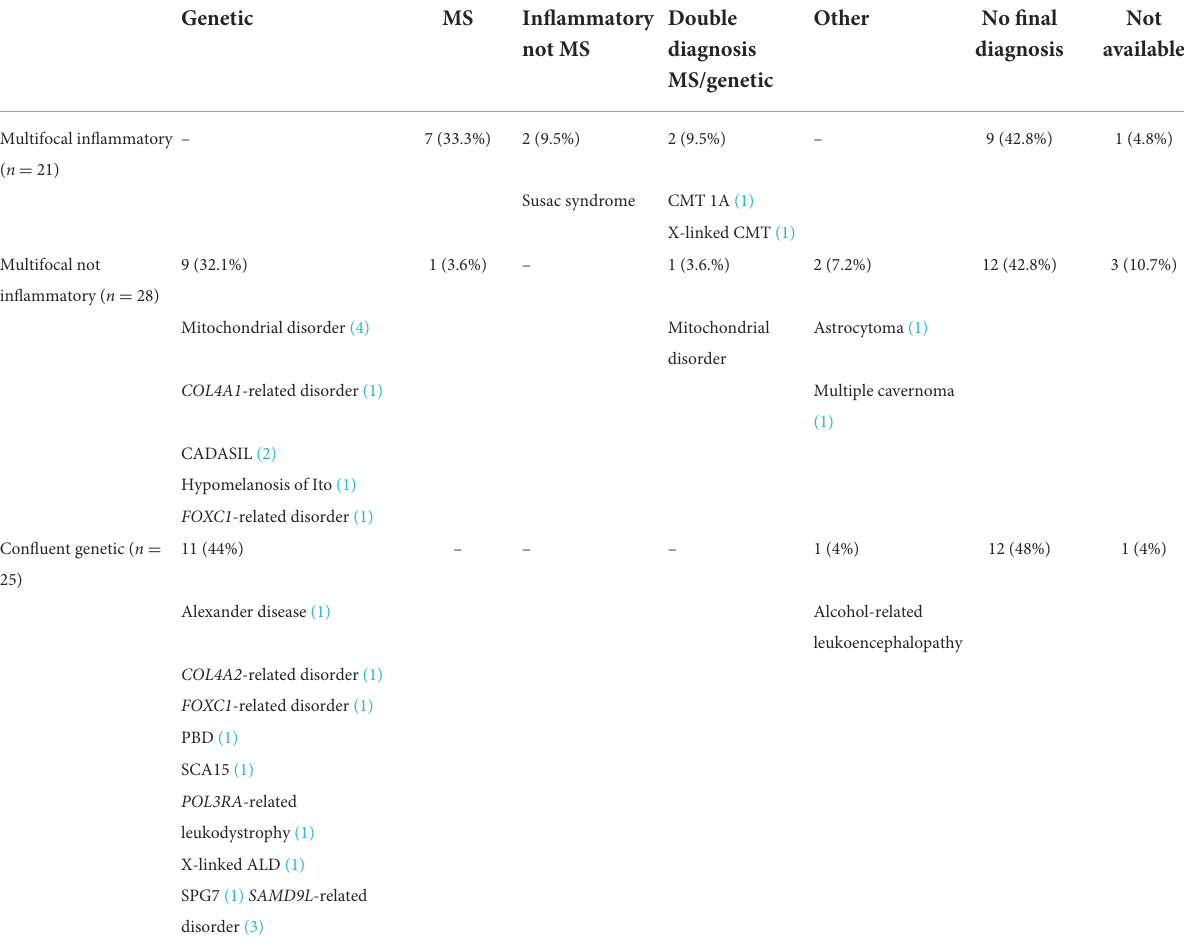
TABLE 2 The definite diagnosis of the 74 patients presented at the WM Rounds according to the interpretation of the MRI findings. Genetic MS Inflammatory